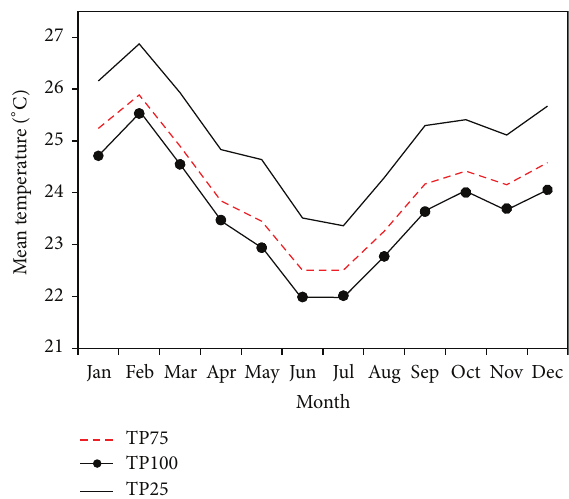
Figure 2: The mean annual cycle of precipitation (in mm/day) for the period 2000–2008, averaged over longitudes 28 ∘ E–42 ∘ E and latitudes 12 ∘ S-5 ∘ N. TP100 is due to the simulation with actual topography (control experiment), TP75 is due to the simulation with topography over KTU reduced to 75%, and TP25 represents simulation when the topography is reduced to 25%.